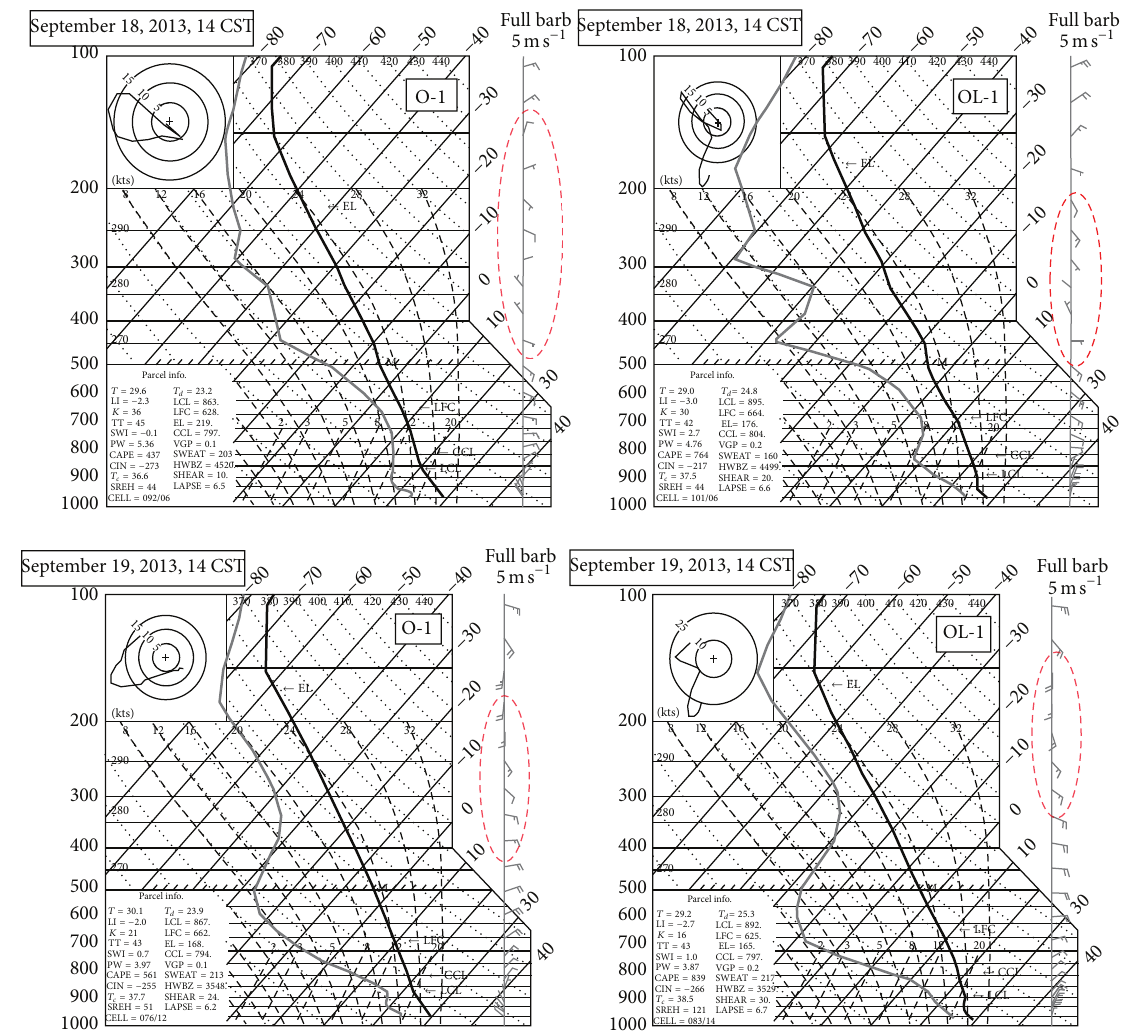
Figure 9: Modeled skew-temperature diagram for Zuoying (O-1) and Magong (OS-1) air quality monitoring stations for the invasion of typhoon Usagi (black line: temperature ( ∘ C); gray line: dew-point temperature ( ∘ C); wind vector full barb = 5